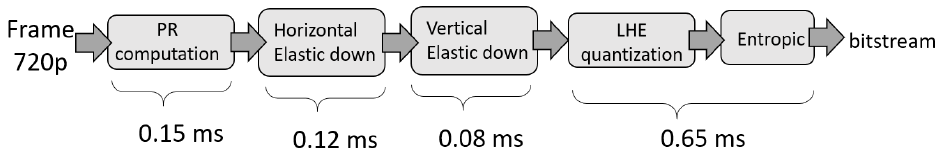
Figure 16. Main phases of Logarithmical Hopping Encoding (LHE) compression.